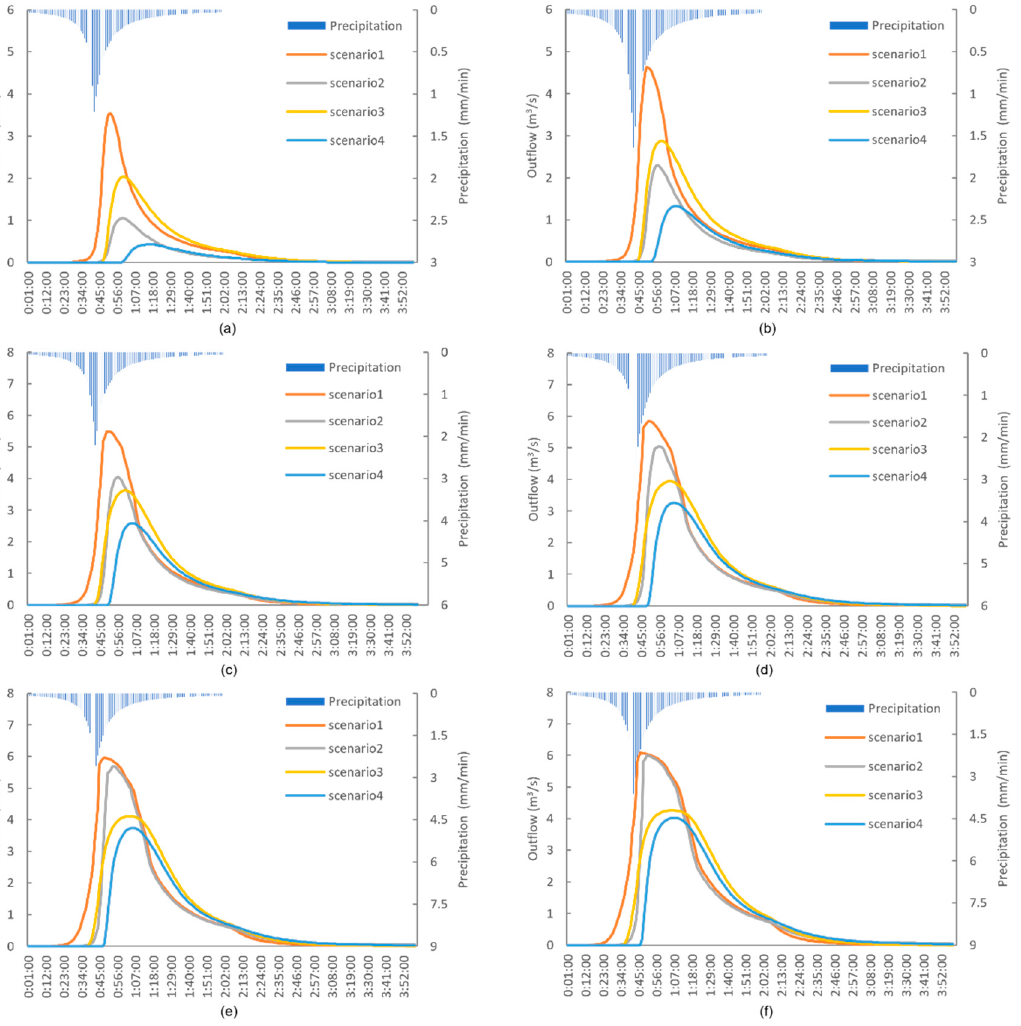
Figure 4. Outflow control effect under different return periods: ( a ) When return period is 1a; ( b ) When return period is 2a; ( c ) When return period is 5a; ( d ) When return period is 10a; ( e ) When return period is 20a; ( f ) When return period is 50a.